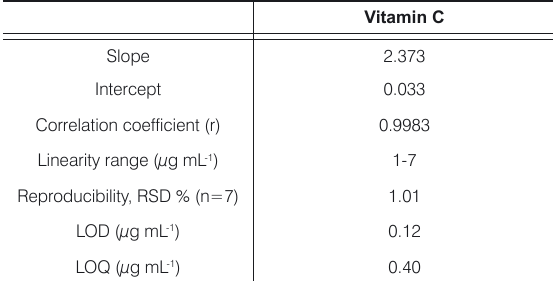
Table 1. Statistical data for the calibration graph of vitamin C standards